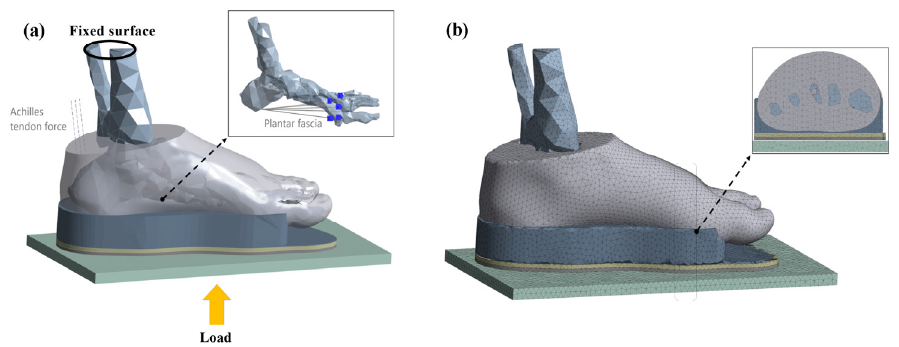
Figure 2. ( a ) The 3D foot model is reconstructed with fixed points and applied load, and ( b ) the 3D foot model is meshed with tetrahedral elements.